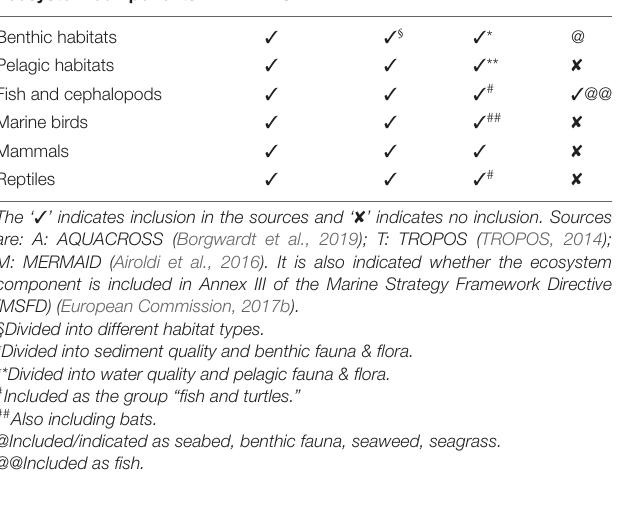
Frontiers in Marine Science |